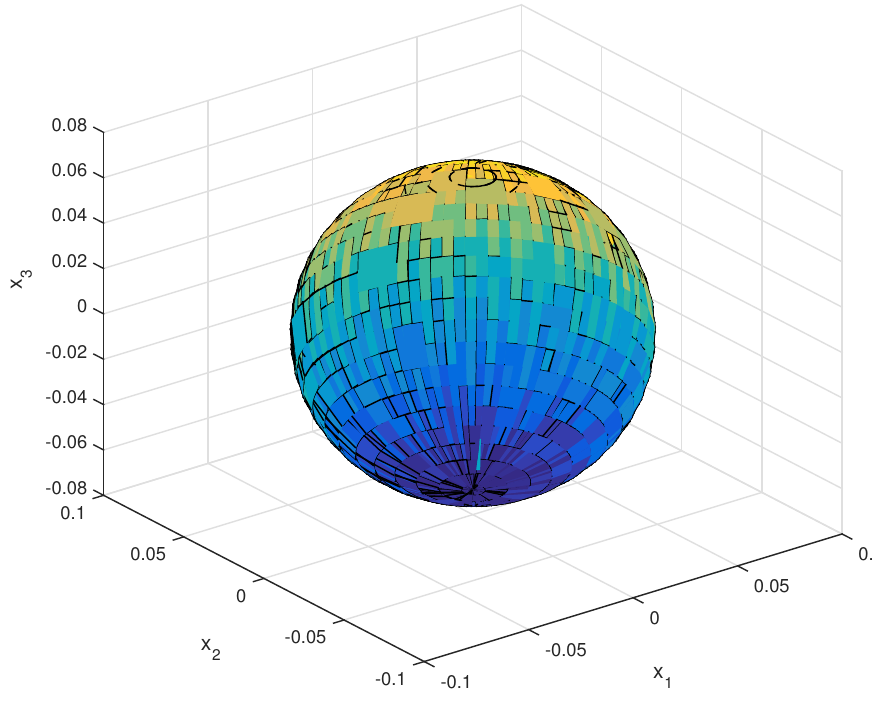
Figure 2. Stability domain B ε in Example